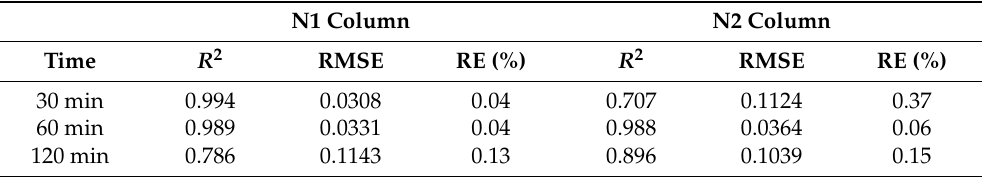
Table 3. Evaluation metrics for different sampling points and